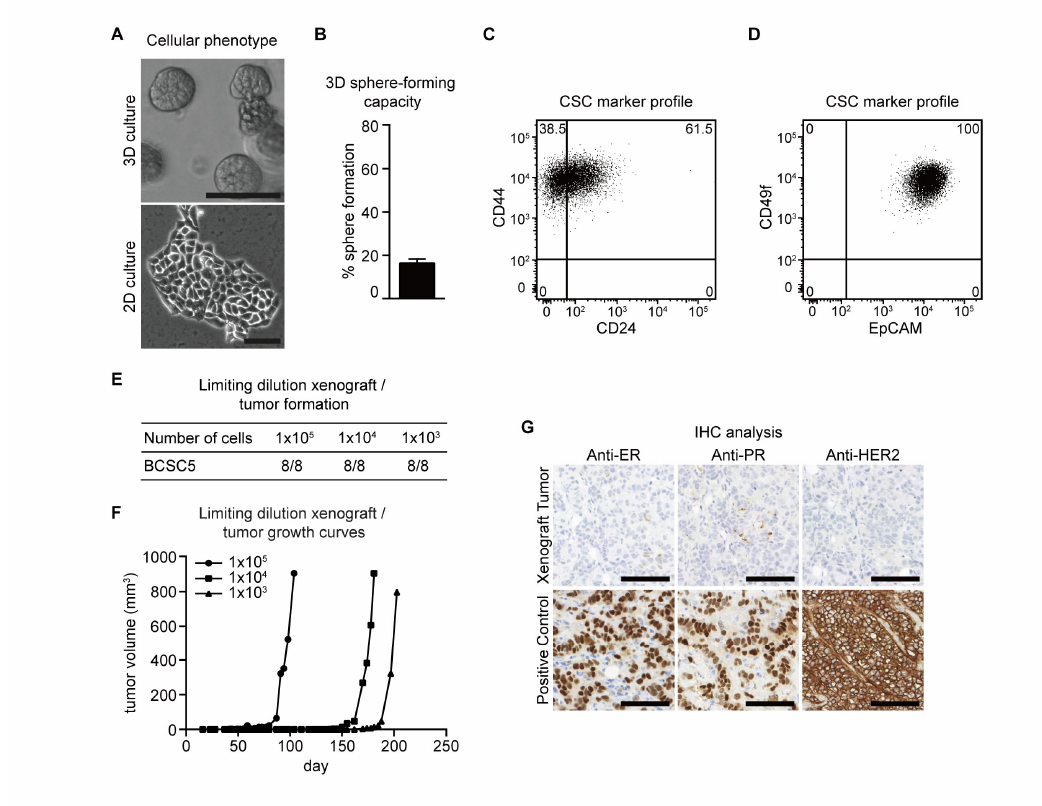
Figure 1. Characterization of BCSC5 in vitro and in vivo. ( A ) Representative pictures of BCSC5 cultured in 3D and 2D conditions, scale bar 100 μ m. ( B ) Sphere ‐ forming capacity of BCSC5 cells in an anchorage ‐ independent growth assay ( n = 3). Data represent means + SEM. ( C , D ) Expression patterns of CD24 and CD44 ( C ) as well as EpCAM and CD49f ( D ) in BCSC5 cells analyzed by flow cytometry. ( E ) Tumor formation in limiting dilution xenografts of BCSC5. ( F ) Representative growth curves for limiting dilution assay of BCSC5 xenografts in immunocompromised NOD/SCID mice. ( G ) Immunohistochemical (IHC) analysis of ER, PR, and HER2 on sections of the BCSC5 xenograft tumors, scale bar 100 μ